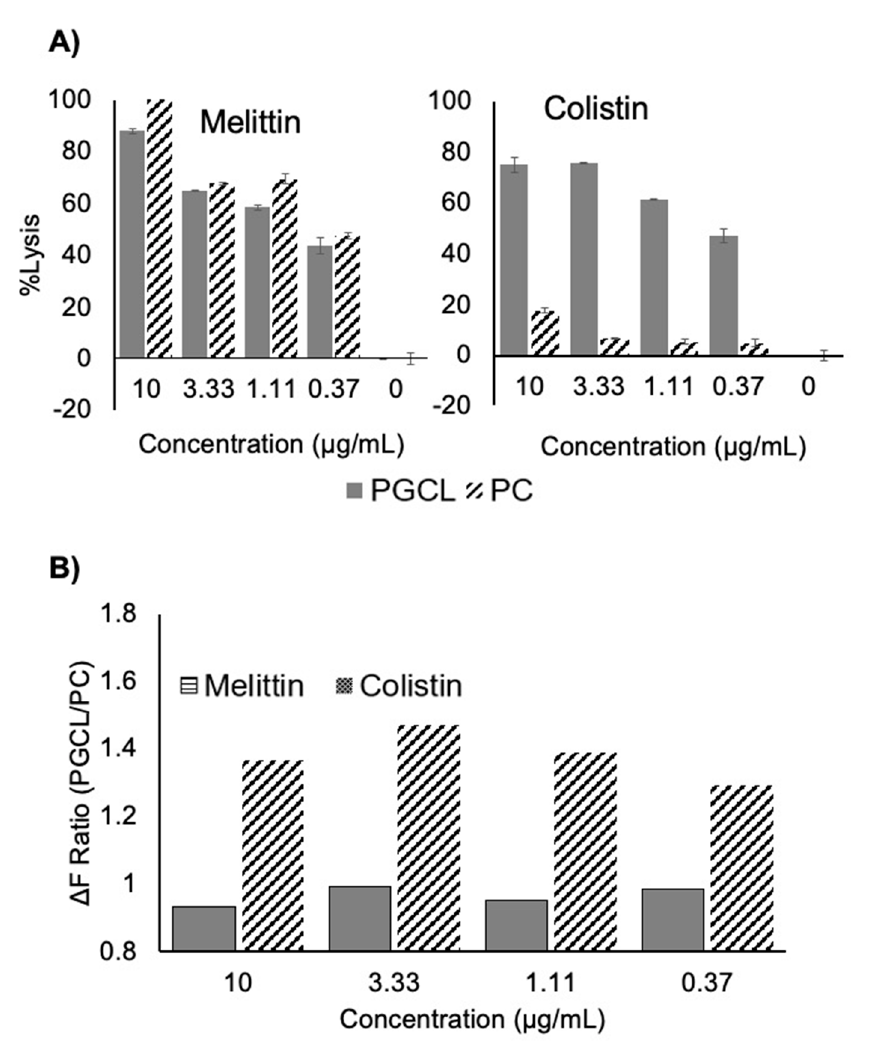
Figure 1. Specificity of the liposome lysis assay. ( A ) Phospholipid-driven specificity in the liposome disruption assay. The left and right panels show the %Lysis of carboxy-fluorescein-loaded liposomes after treatment with various concentrations of melittin or colistin. ( B ) PGCL/PC lytic ratio. The lytic ratio is calculated to identify treatments that lyse PGCL liposomes over PC liposomes, as described in the text. This figure shows that the lytic ratios at all concentrations are approximately 1.0 for melittin and are ˃ 1.0 for colistin. This indicates that melittin shows little to no specificity and colistin has specificity for PGCL liposomes.